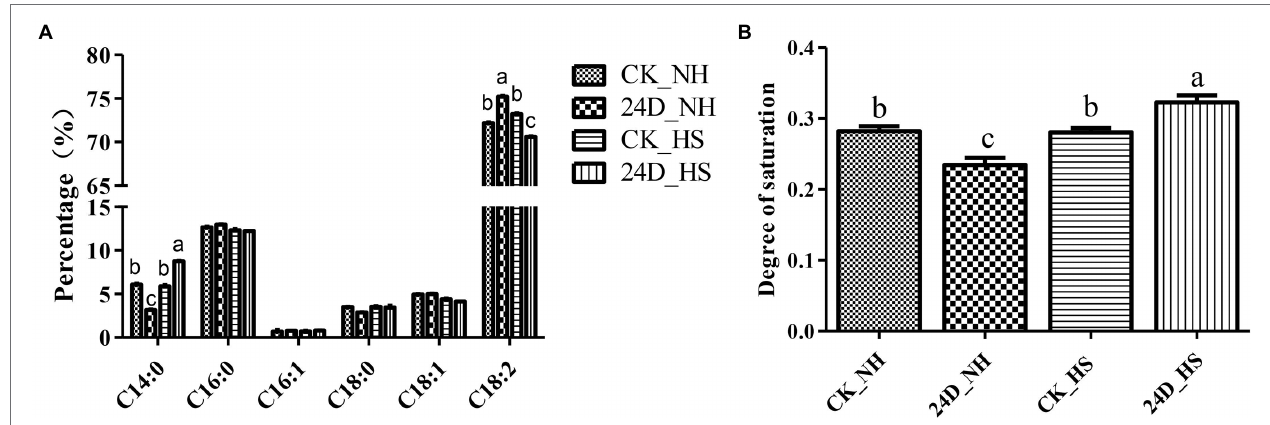
FIGURE 4 | Analysis of fatty acid composition and saturation degree of CK_NH, CK_HS, 24D_NH, and 24D_HS samples. (A) Percentage for each fatty acid content obtained by normalization with internal standards. (B) The saturation degree of fatty acids determined by the rate of saturated to unsaturated fatty acids. Total unsaturated fatty acids to the sum of C16:1, C18:1, and C18:2; total saturated fatty acids to the sum of C14:0, C16:0, and C18:0. Different small letters indicate significant differences between samples ( p <